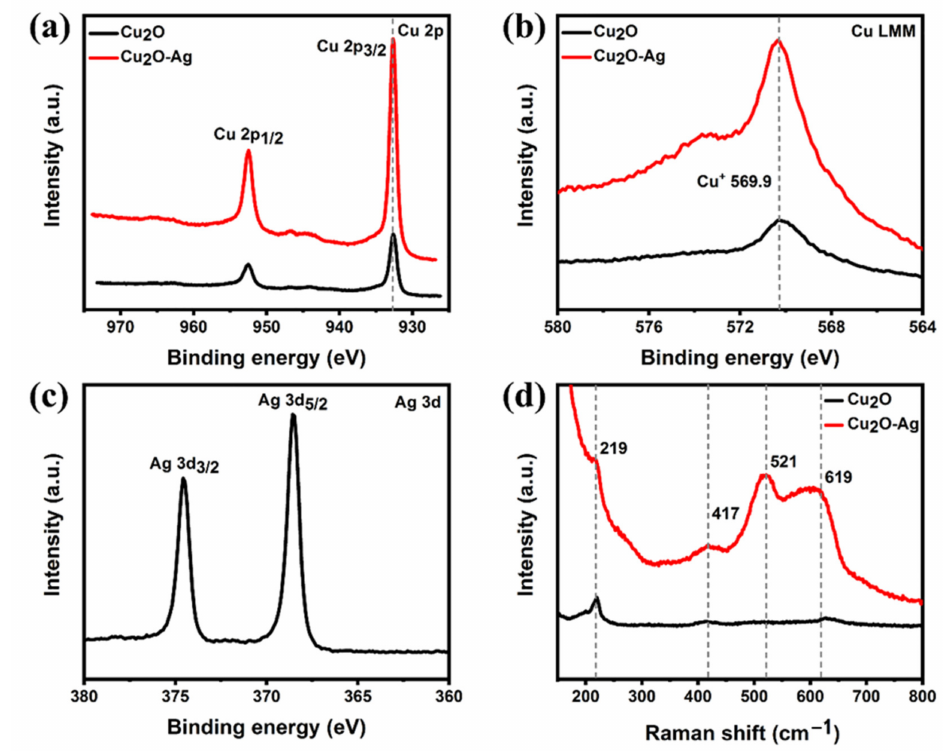
Figure 2. ( a ) XPS Cu 2p spectra. ( b ) Auger spectra of Cu LMM. And ( c ) XPS Ag 3d spectra